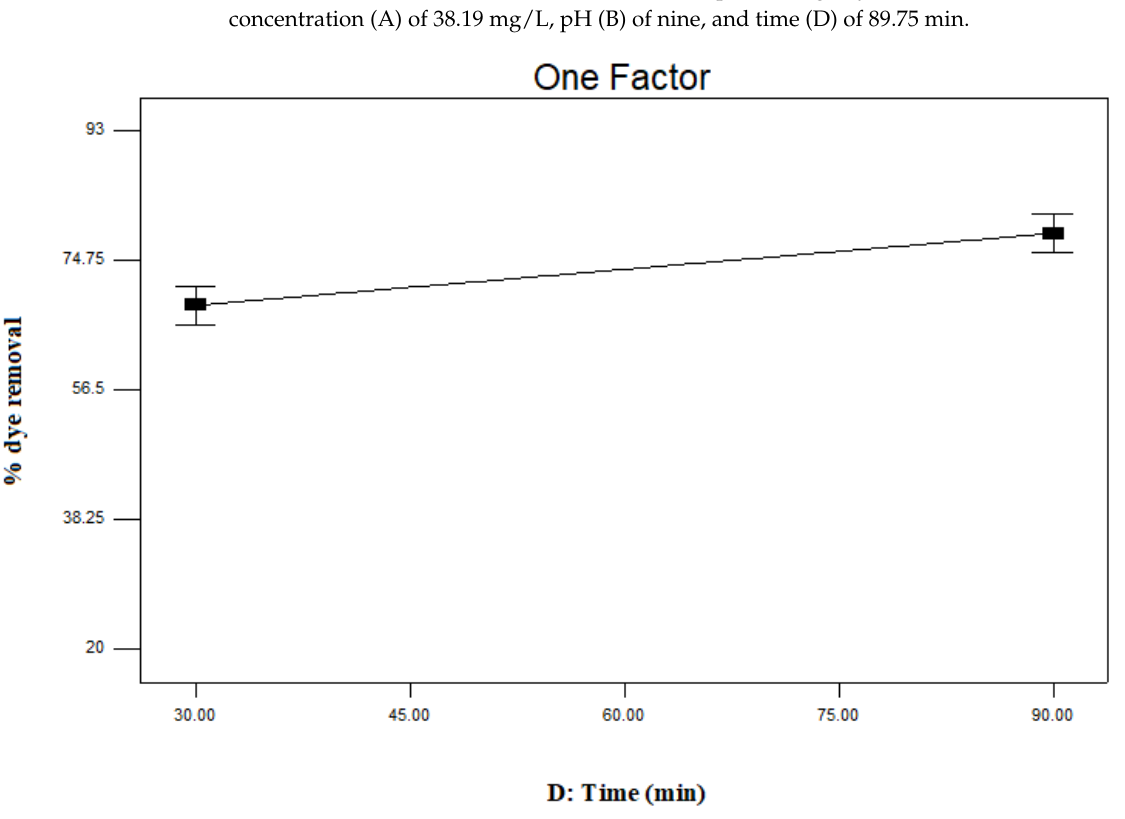
Inorganics 2022 , 10 , x FOR PEER REVIEW 13 of 22